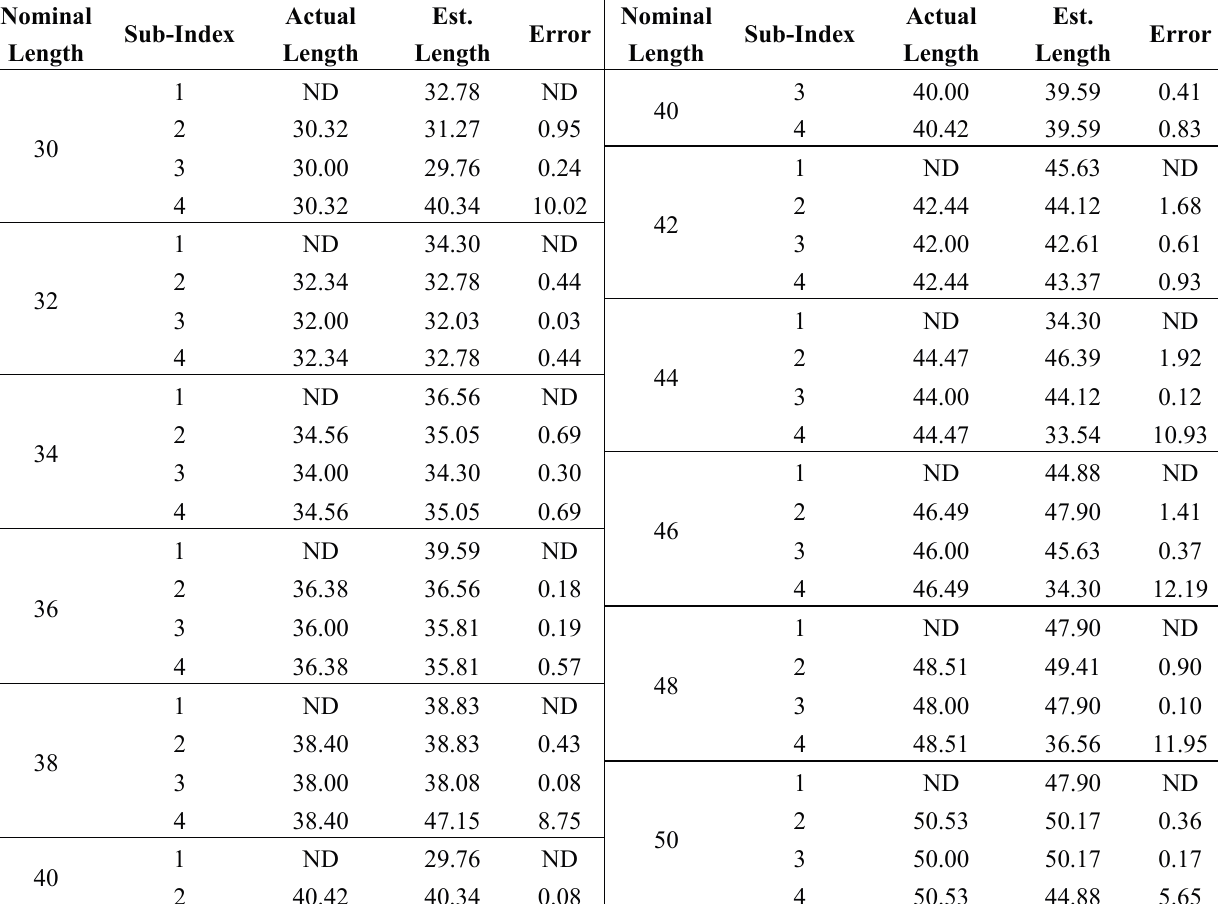
Table 2. ML system performance results. (ND is Not